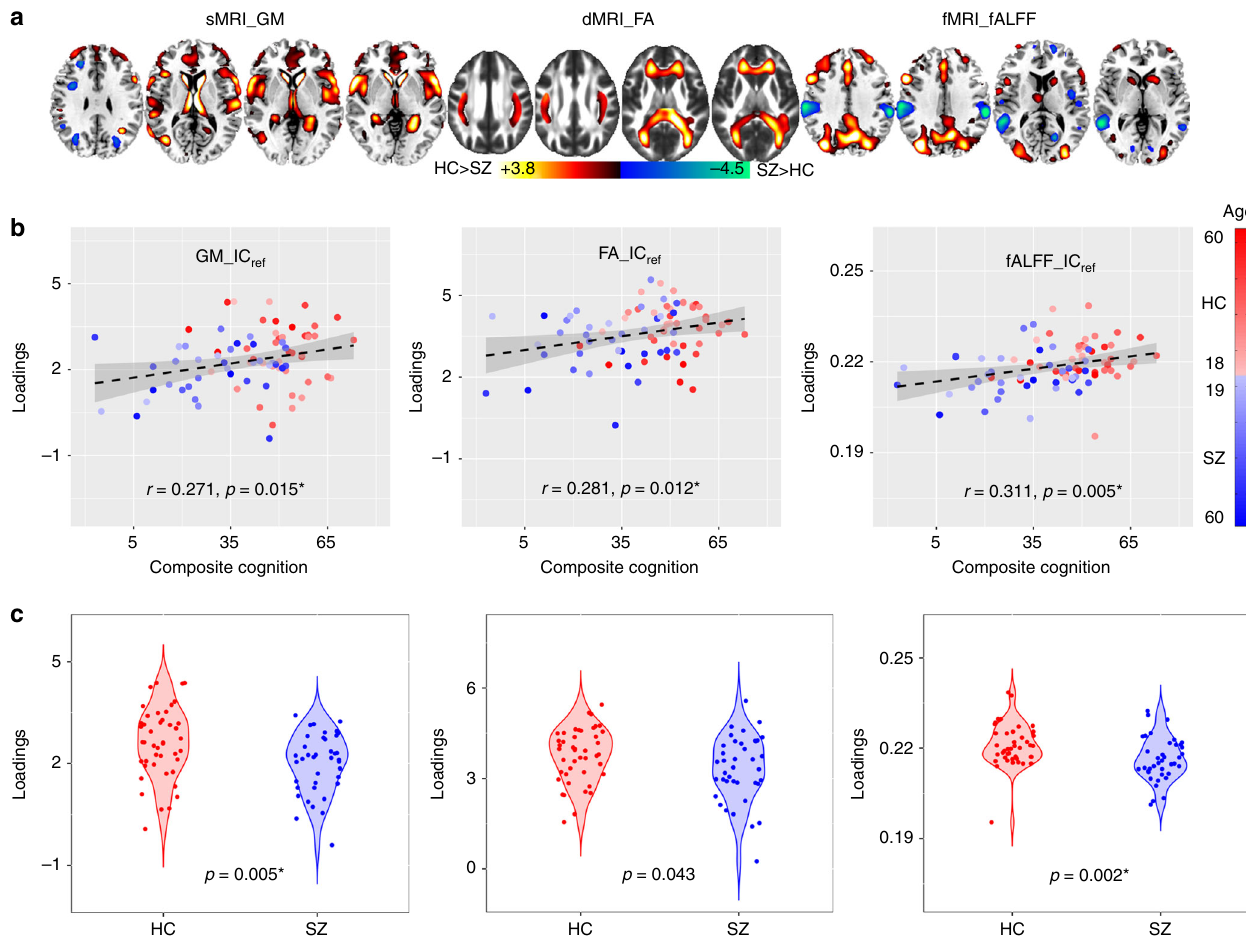
Fig. 2 The identi fi ed joint components for UNM cohort. a The brain maps visualized at | Z | > 2; the positive values (red) means SZ < HC and the negative values (blue) means SZ > HC. b Correlations between loadings of IC ref and MCCB composite scores (HC: the red dots, SZ: the blue dots); thus SZ corresponds to worse cognitive performance and lower loading weights compared to HC. c Boxplot of the loading parameters of UNM_IC ref_composite that were adjusted as HC > SZ on the mean of loadings for each modality, with two sample t -tests p values between HC and SZ as shown at the bottom. The gray regions in b indicate a 95% con fi dence